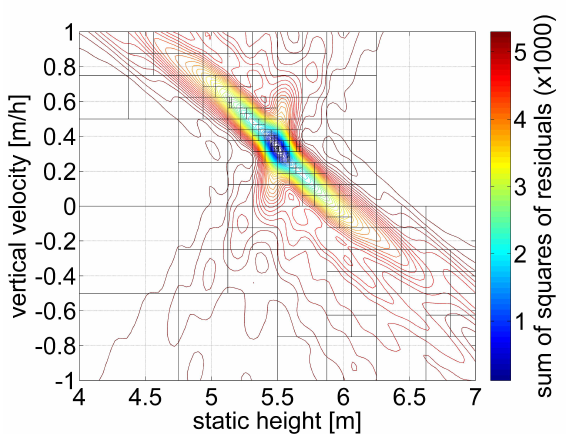
Figure 2: Contour plot of the cost functions from Eq. (4) with the intervals boxes investigated by the